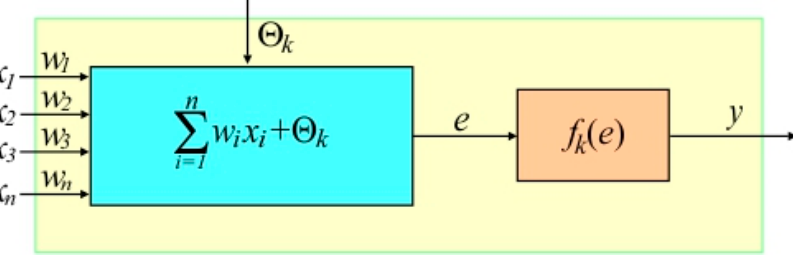
Figure 3. Structure of the nonlinear k -th neuron.